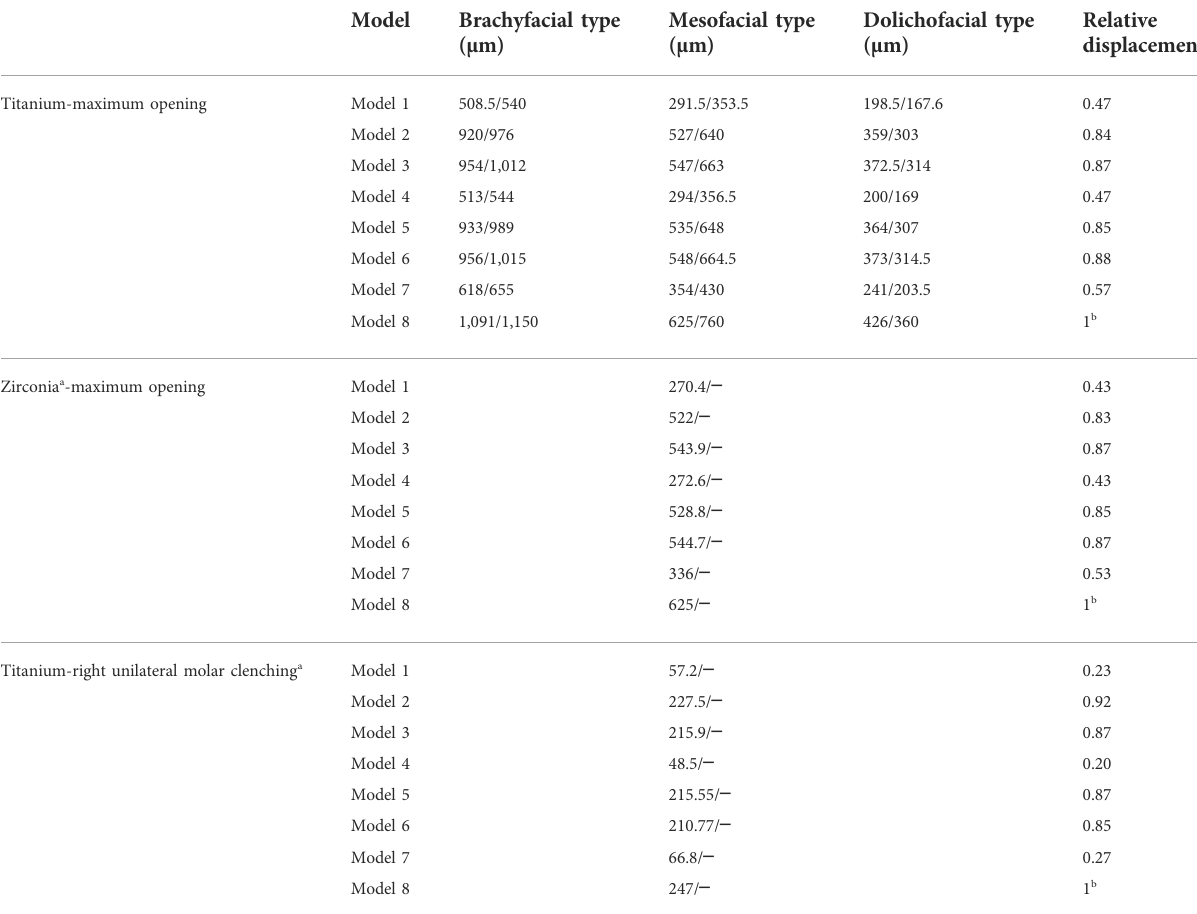
TABLE 7 Mandibular displacement at the bilateral fi rst molar level in different facial types and genders in the mandibular opening and clenching